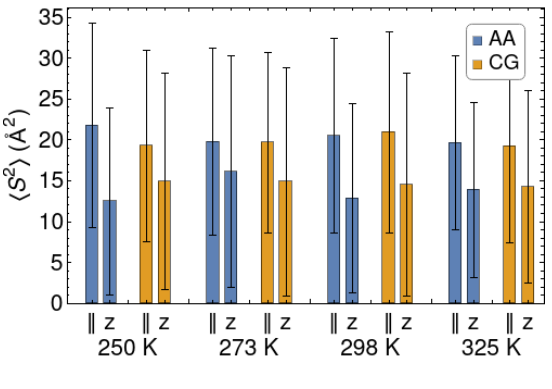
Figure 4. Gyration tensor components for the Q 4 surface at different temperatures, for the AA and CG models. The zz component is indicated as z , while the averaged xx , yy component is indicated with the “ || ” symbol (parallel, planar). The “error bars” indicate the standard deviations of the